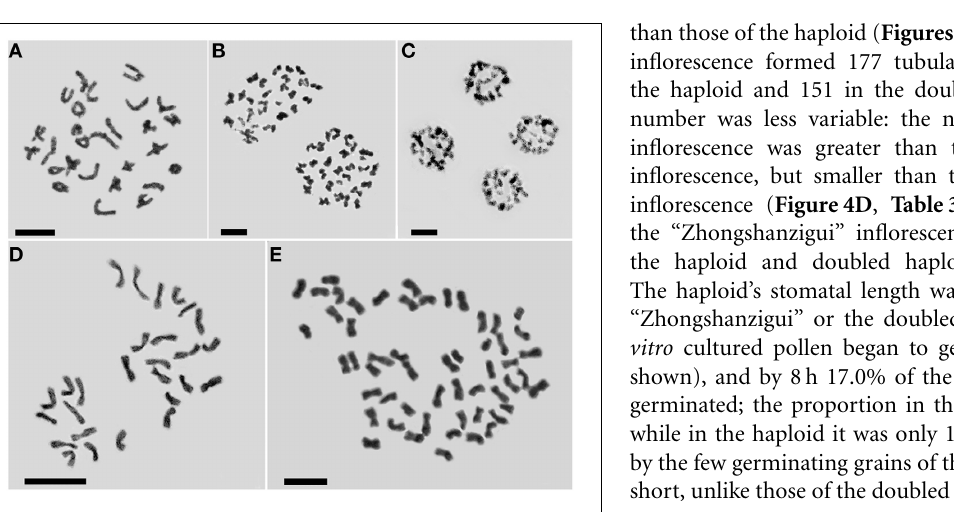
FIGURE 2 | Cytological characterization of C. morifolium cv. “Zhongshanzigui” and its haploid and doubled haploid derivatives. (A–C) Meiotic chromosomes in the cv. “Zhongshanzigui” pollen mother cell: (A) metaphase I, (B) anaphase I, (C) telophase II. Somatic chromosomes in (D) haploid and (E) doubled haploid plants. Bar: 5 μ